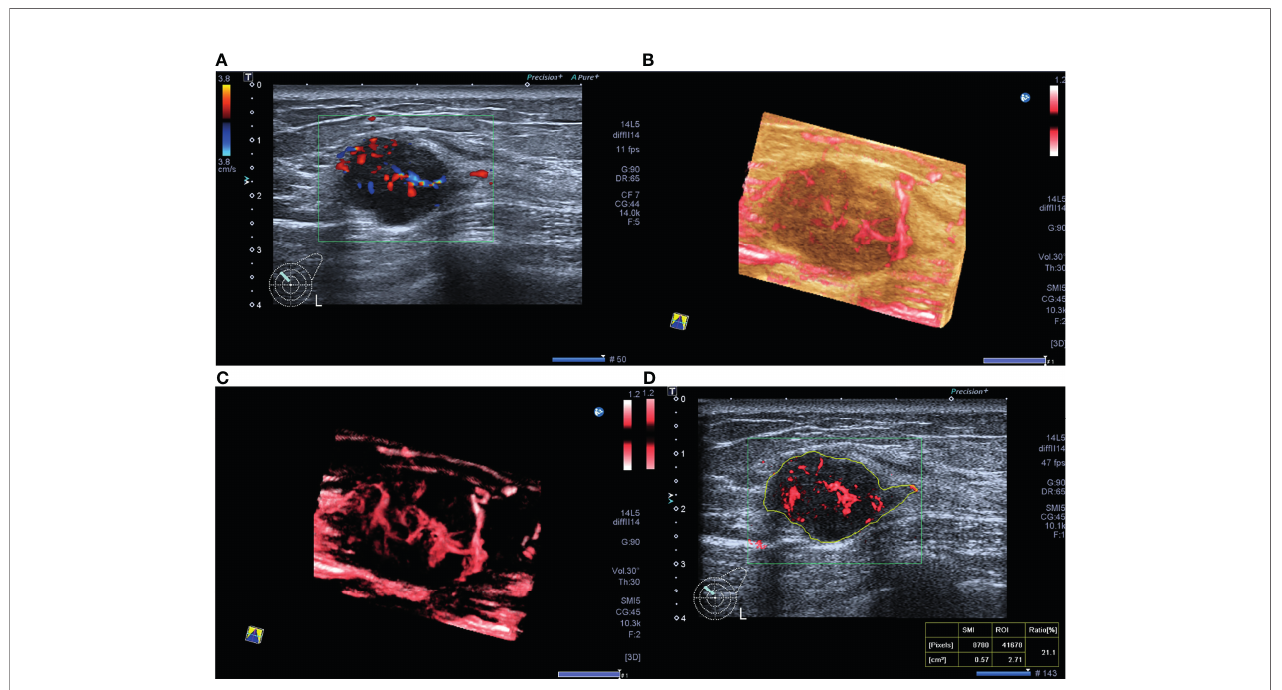
FIGURE 3 | A 40-year-old woman with triple-negative invasive ductal cancer [2.3 cm, ER (-), PR (-), HER-2(-), Ki-67 95%, nuclear grade 2, T2N1M0]. (A) Color Doppler fl ow image shows abundant and disordered blood fl ow signals. (B, C) Smart three-dimensional superb microvascular imaging reveals detailed and abundant vascular architecture with crab claw-like blood fl ow. (D) Vascular index was measured on the plane containing the most abundant vasculature with a value of